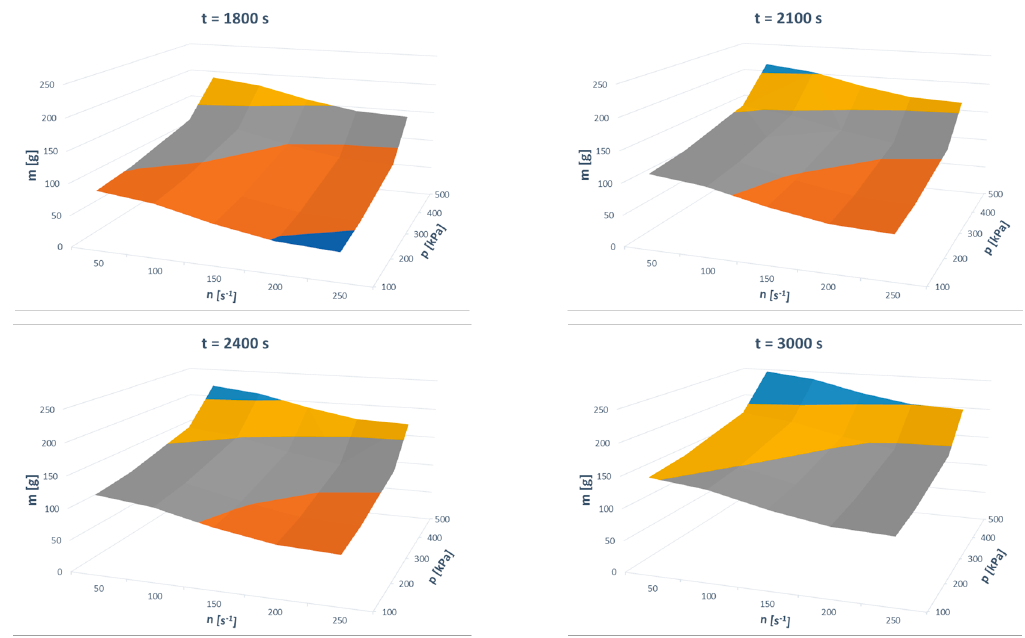
Figure 11. Effects of input parameters on the mass of grinding product.